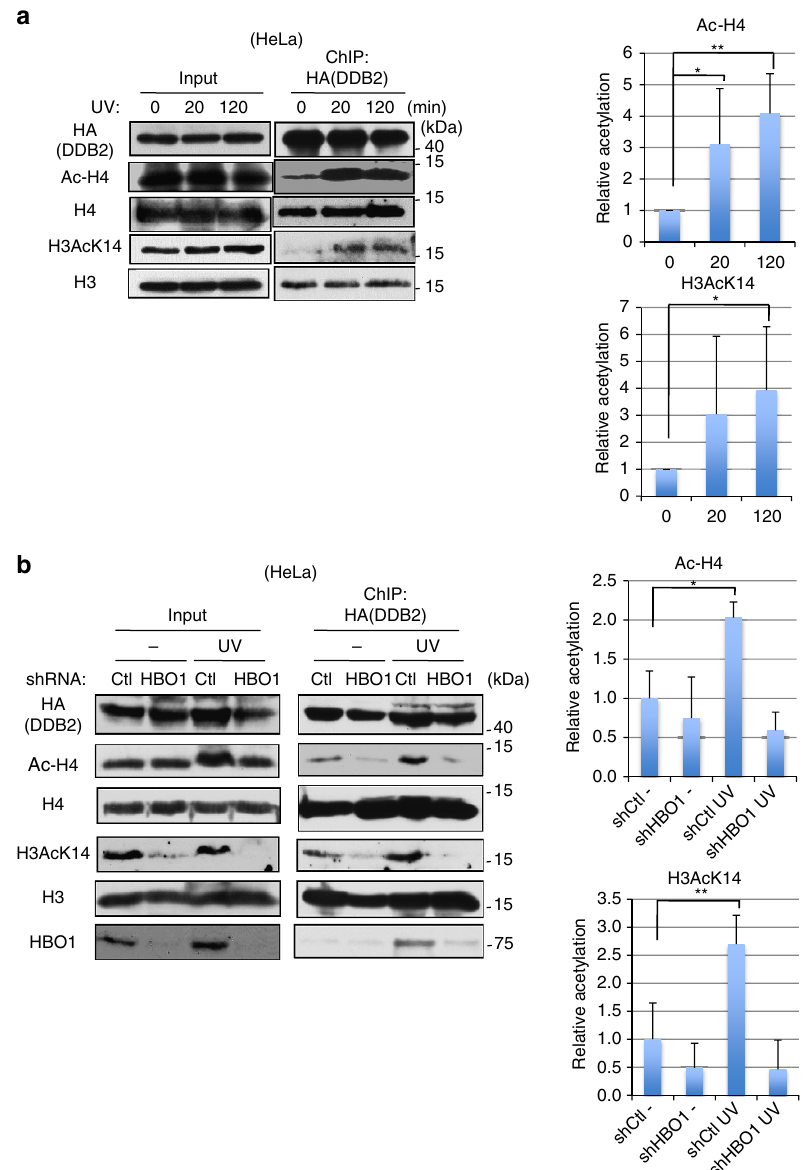
Figure 4 | HBO1 acetylates histone H3 and H4 around DDB2-bound chromatin after ultraviolet irradiation. ( a ) Acetylation levels of histone H3 Lys 14 and histone H4 around HA-DDB2-bound chromatin were increased after ultraviolet irradiation. Transiently expressing HA-DDB2 cells were irradiated with 40Jm (cid:2) 2 ultraviolet and collected at 0, 20 and 120min. Cells were cross-linked and immunoprecipitated as described in Methods. Immunoprecipitates were then subjected to western blotting with the indicated antibodies. Signal intensities were quantitated using ImageJ. Error bars indicate means ± s.d. from seven independent experiments. * P o 0.05; ** P o 0.01 (Student’s t -test). ( b ) Acetylation levels of histones around HA-DDB2-bound chromatin after ultraviolet irradiation were HBO1-dependently increased. HA-DDB2-expressing shCtl and shHBO1 cells were mock irradiated or irradiated with 40Jm (cid:2) 2 ultraviolet and collected after 20min ultraviolet irradiation. ChIP-western blotting was performed as described in a . Signal intensities were quantitated using ImageJ. Error bars indicate means ± s.d. from five independent experiments. * P o 0.05, ** P o 0.01 (Student’s t